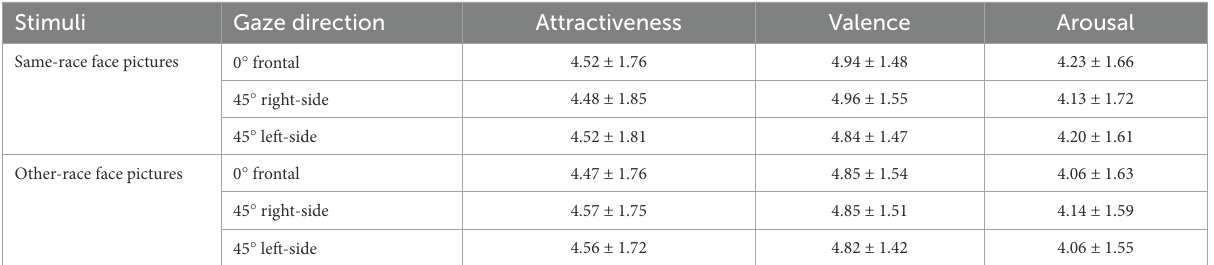
TABLE 1 Results of the stimuli assessment task (M ± SD).